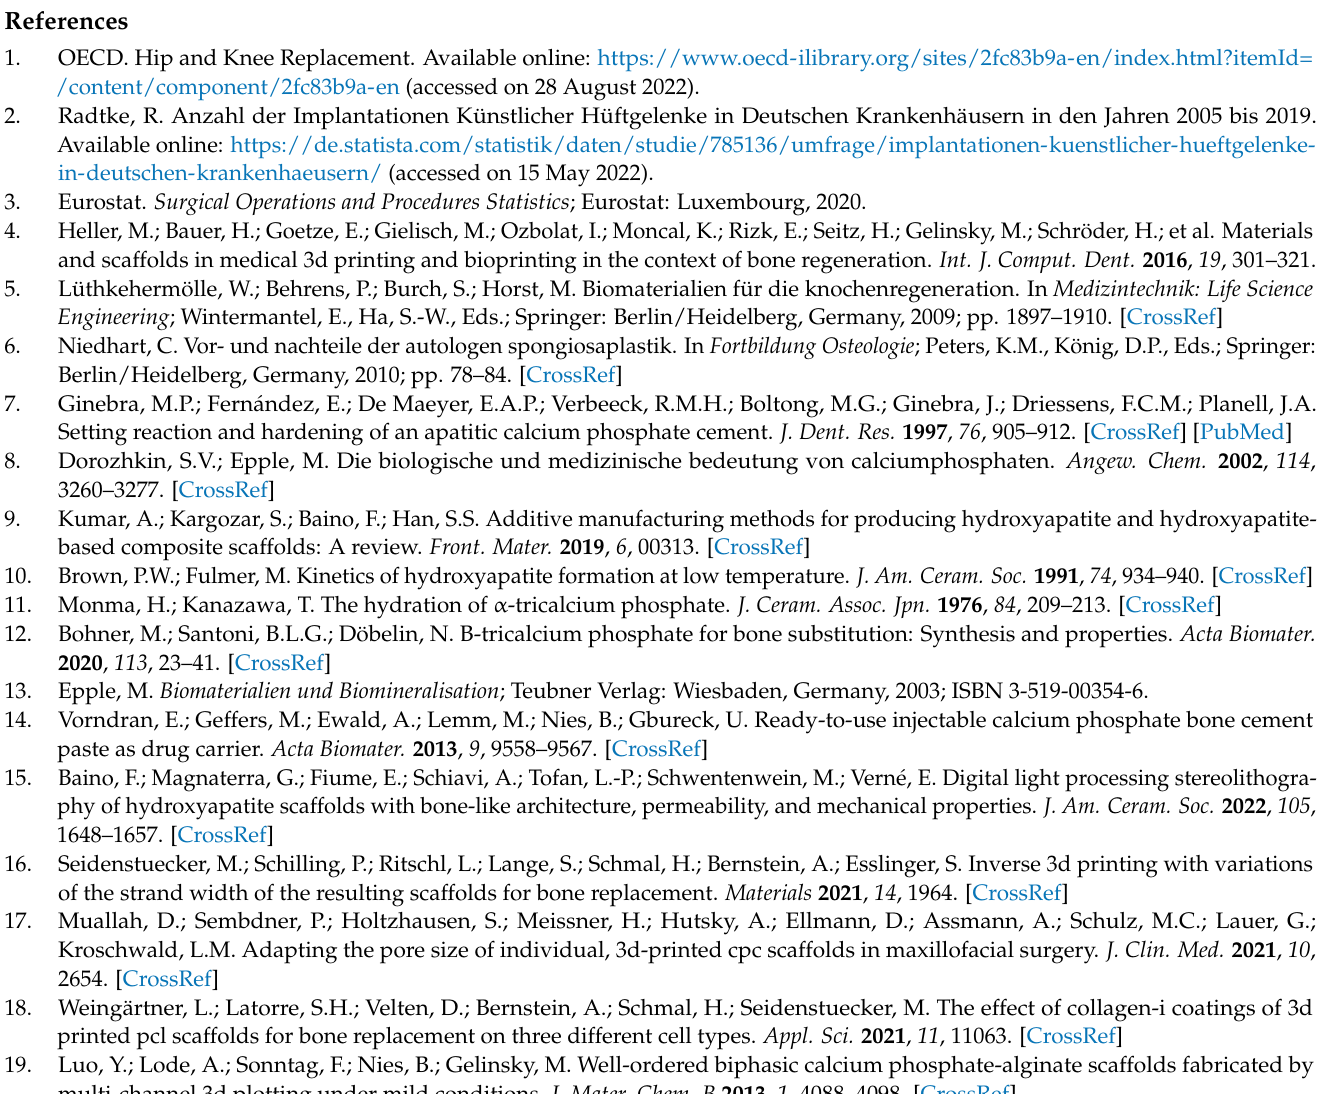
Figure A3. Compressive strength for the different